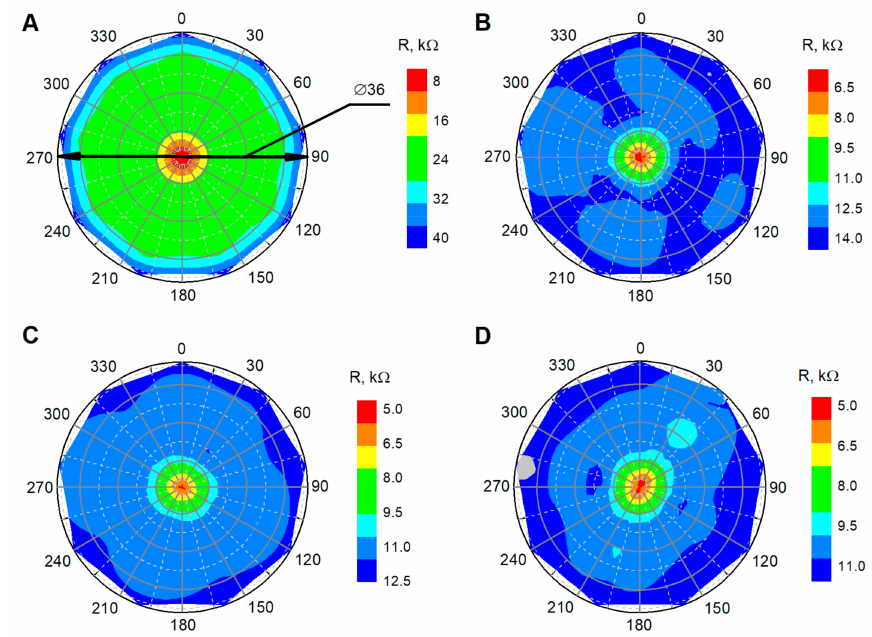
Figure 6. Resistance distribution of ( A ) 0.14 N, ( B ) 0.96 N, ( C ) 2.20 N and ( D ) 3.02 N load, 2D